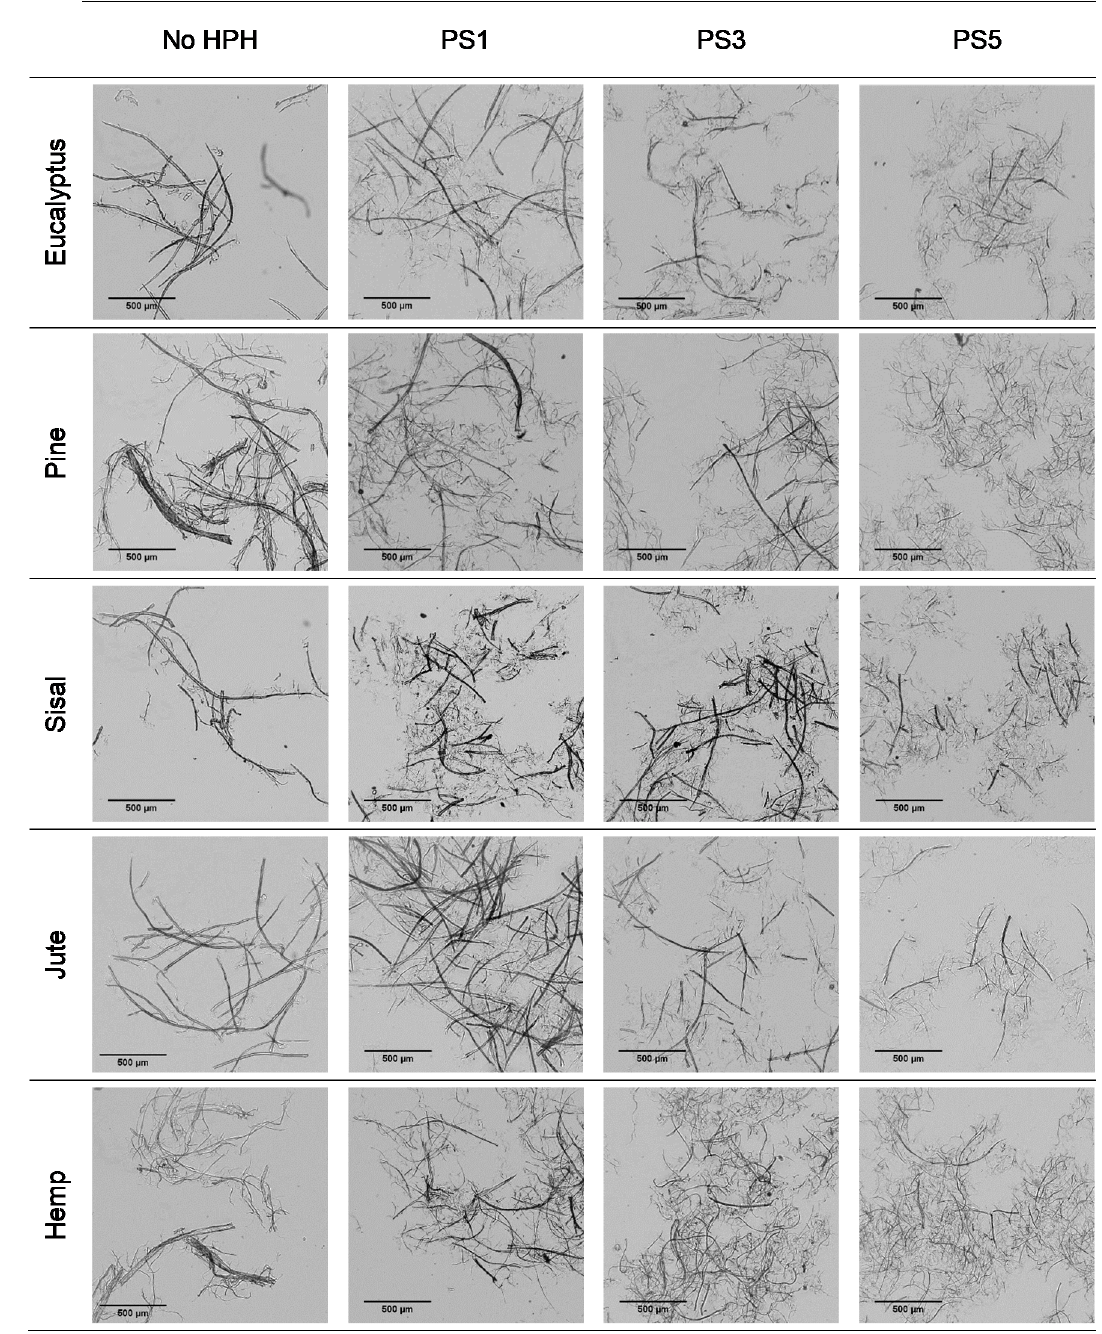
Figure 1. Optical microscopy images at 5× magnification of pretreated cellulose and CMF/CNFs with the mechanical pre- Figure 1. Opticalmicroscopyimagesat5 × treatment.